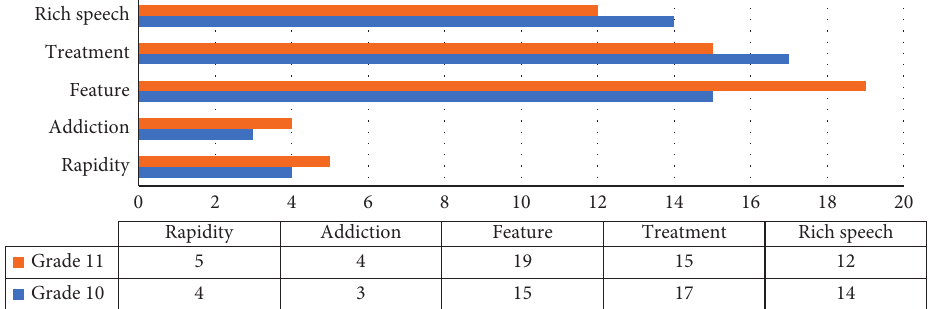
Figure 4: Initial level of creativity and communication skills of